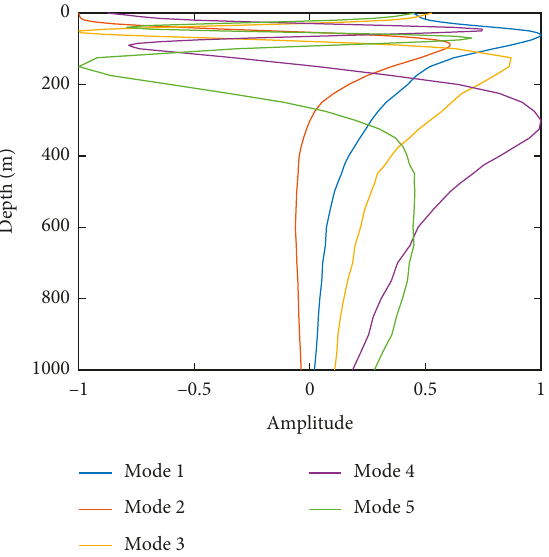
Figure 4: The normalized amplitude of the first five EOFs.